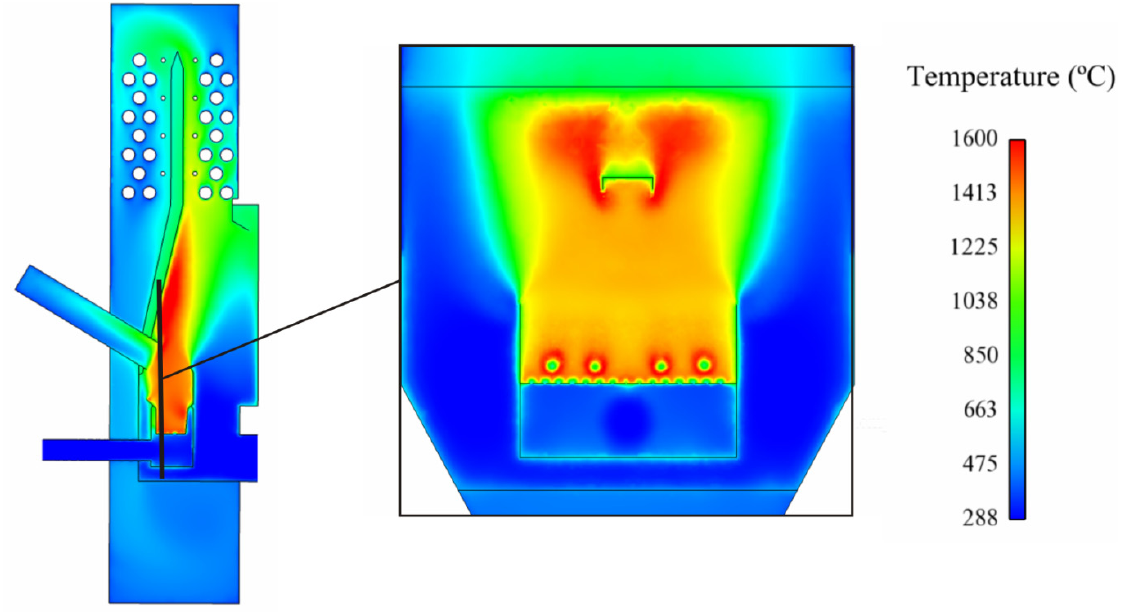
Figure 4. Gas temperature (°C) contours of a central axis section and a frontal view of the